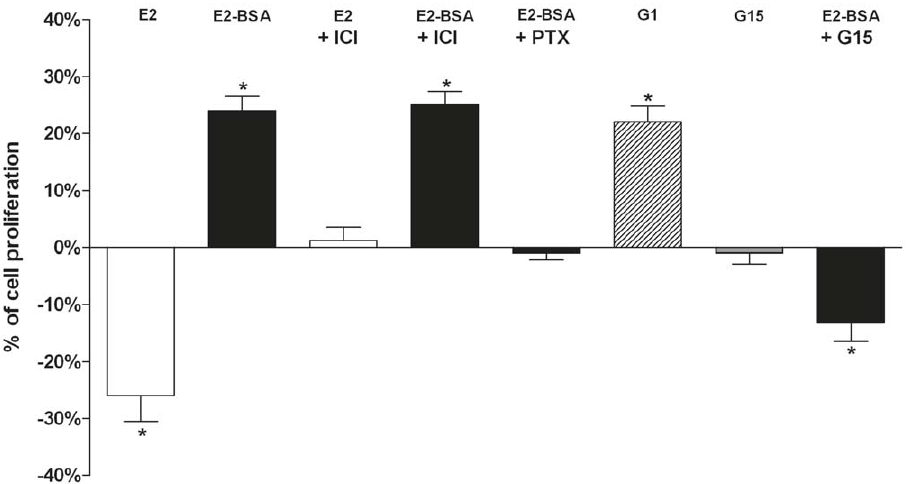
Figure 4. GPER triggers JKT-1 cell proliferation in vitro. JKT-1 cells were seeded in six-well plates (0,6 6 10 6 cells/well). After 48 h, the JKT-1 cells were washed and oestrogen starved overnight in phenol red-free DMEM supplemented with 1% charcoal-stripped FBS. Serum-deprived JKT-1 cells were then incubated for 24 h with E2-BSA (1 nM), an impermeable E2-conjugate, which cannot thus interact with classical nuclear or cytoplasmic estrogen receptors, after a pre-treatment with G15 (1 nM), a GPER antagonist, or ICI-182,780 (1 m M), a pure ER antagonist, or pertussis toxin (100 ng/ mL), a GPCR protein inhibitor. G1 (1 nM), a GPER-specific agonist, was used as a positive control. E2 at the same concentration (1 nM), which induces an inhibitory effect on cell proliferation neutralized by ER antagonist ICI (1 m M), was used for comparison. Histograms represent percentages of variation in the JKT-1 cell number compared with the control (0%), which was measured at 1,2 6 10 6 cells/well after 24 hours of incubation in the steroid-free medium with ethanol (10% of variation represent an increase or a decrease of 60 000 cells). All results are expressed as means 6 SEM of three independents experiments. * P , 0.01. doi:10.1371/journal.pone.0034672.g004 cannot completely eliminate a truncated splice variant form of support the direct implication of GPER. Using RNAi silencing ER a or ER b in JKT-1 not recognized by our primers (PCR) or by and G15, a selective GPER antagonist, we definitively demon- our antibodies (Western blotting) such as ER- a 36, our data strated the involvement of GPER in E2-BSA-induced JKT-1 cell